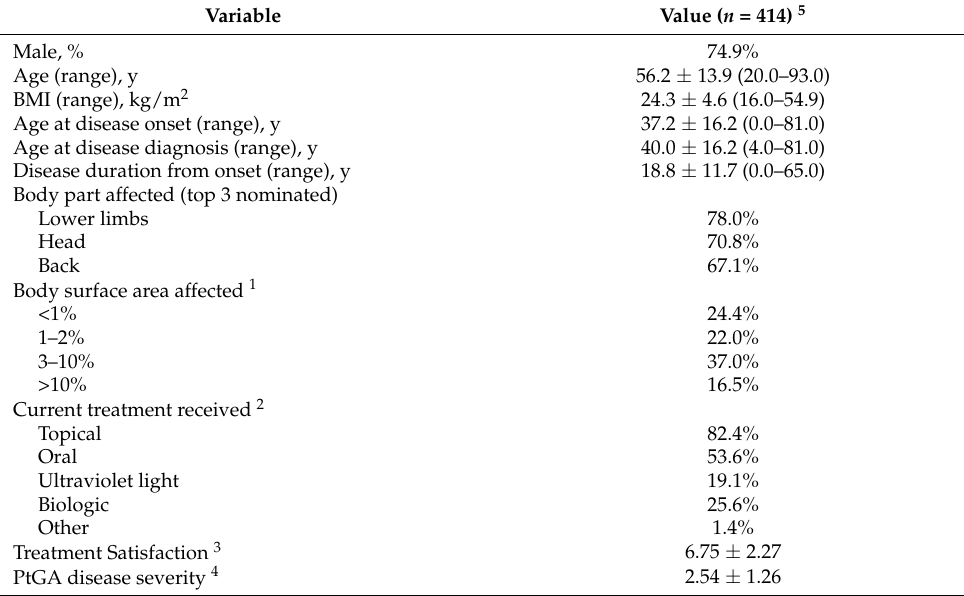
Table 1. Patient characteristics.